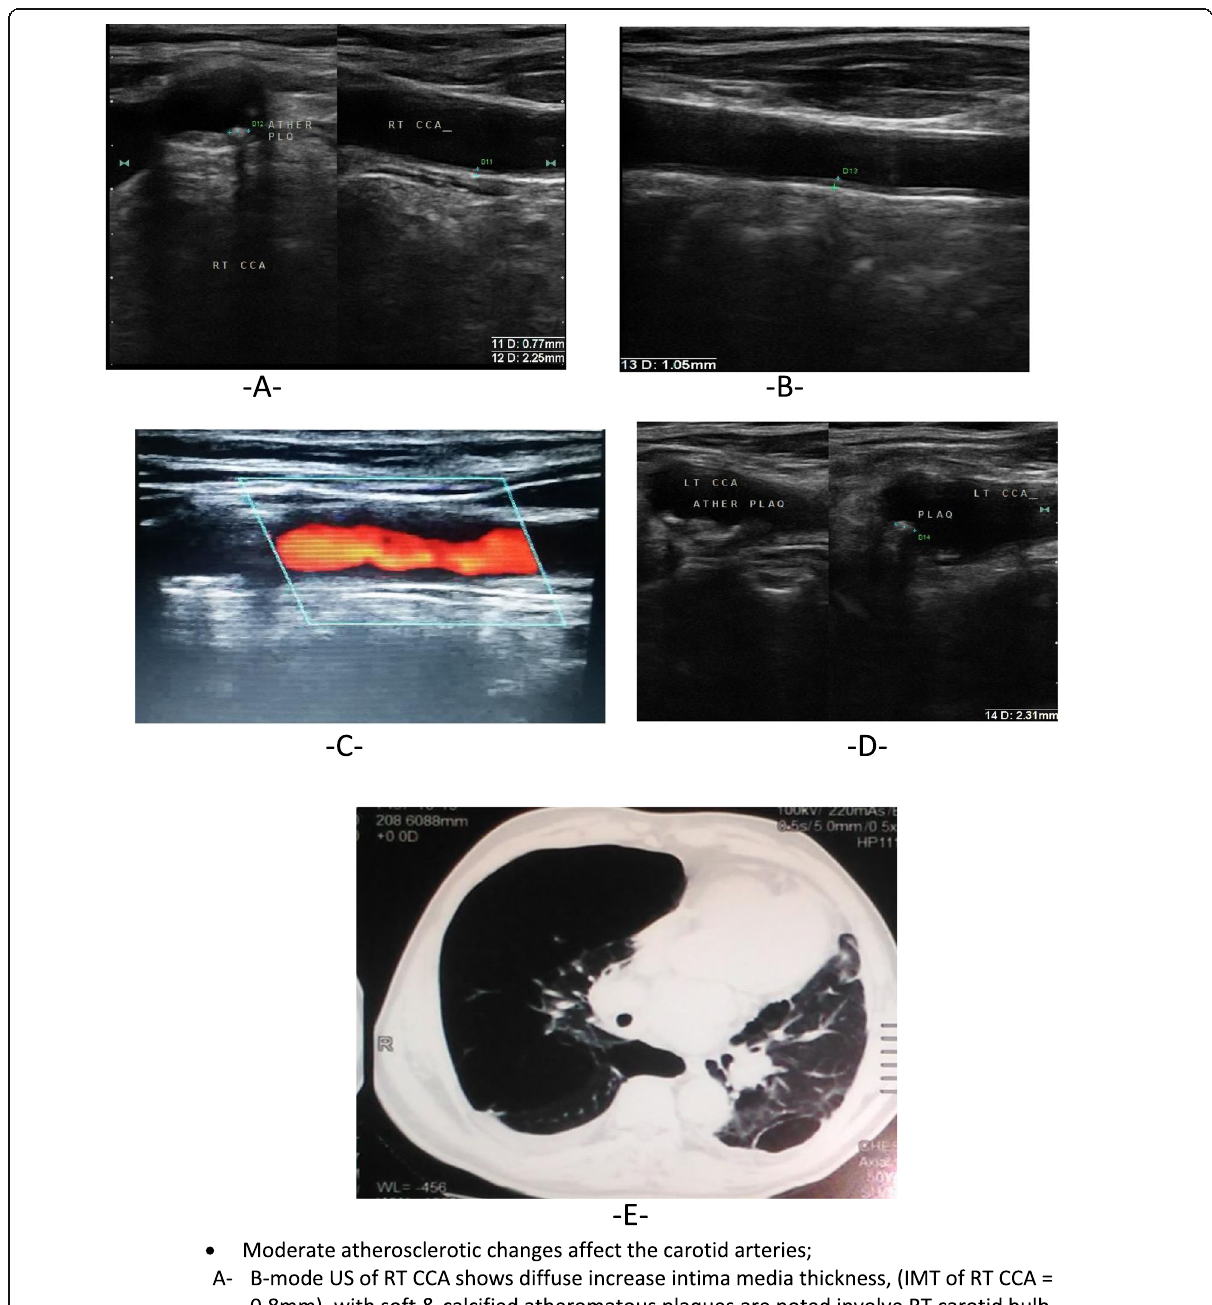
Fig. 5 A case of severe emphysematous changes and moderate carotid arteries atherosclerotic